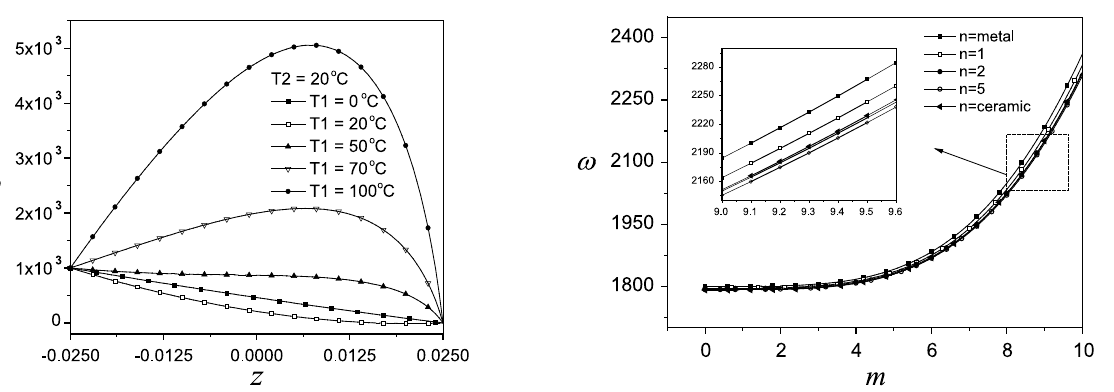
Fig. 10. Distribution of the electric potential φ along z -axis for the clamped supported FGPM cylindrical shell imposed by different thermal loads ( q = 1 MPa, a = 1 m, L = 4 m, a/h = 20 , φ 1 = 1000 , φ 2 = 0 ).